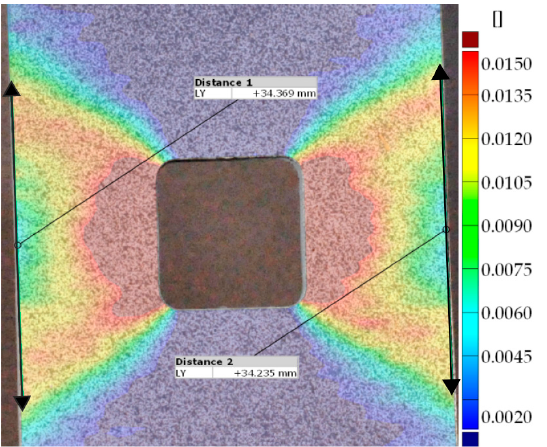
Figure 19. Distribution of strains for sample 3 (without overlays) for ε TOT = 0.48%.